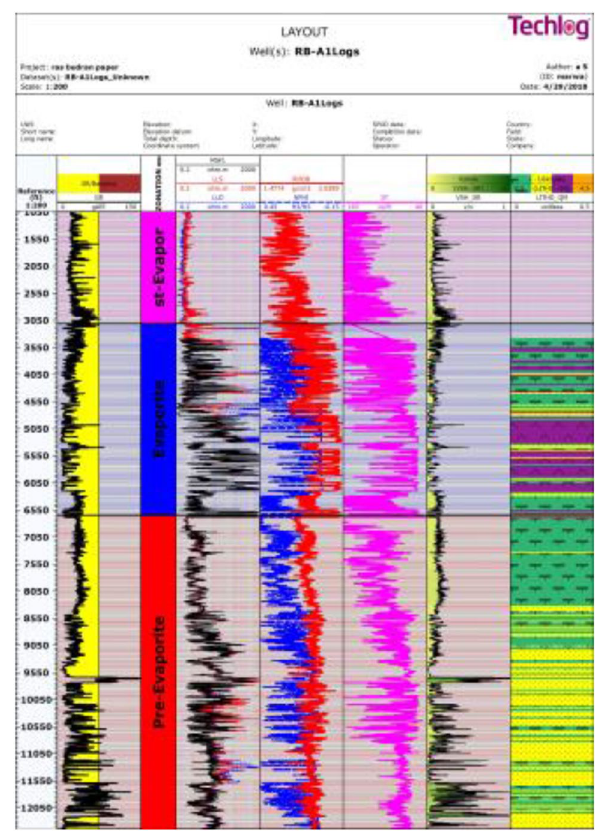
Fig. 6 Litho-saturation cross plot of RB-A1